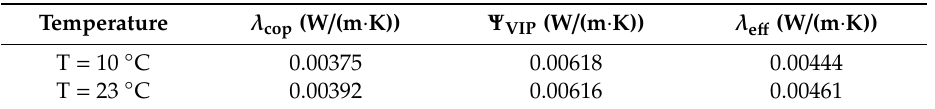
Table 3. E ff ective thermal conductivity and linear thermal transmittance values obtained by the guarded hot plate method.